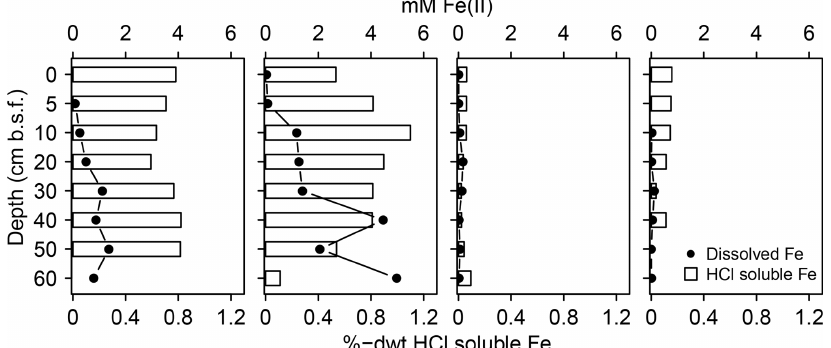
Figure 5. Mobile Fe species. Available solid iron was extracted as HCl soluble iron from the sediment matrix and is composed of iron mono-sulfide and non-sulfidized ferric Fe.